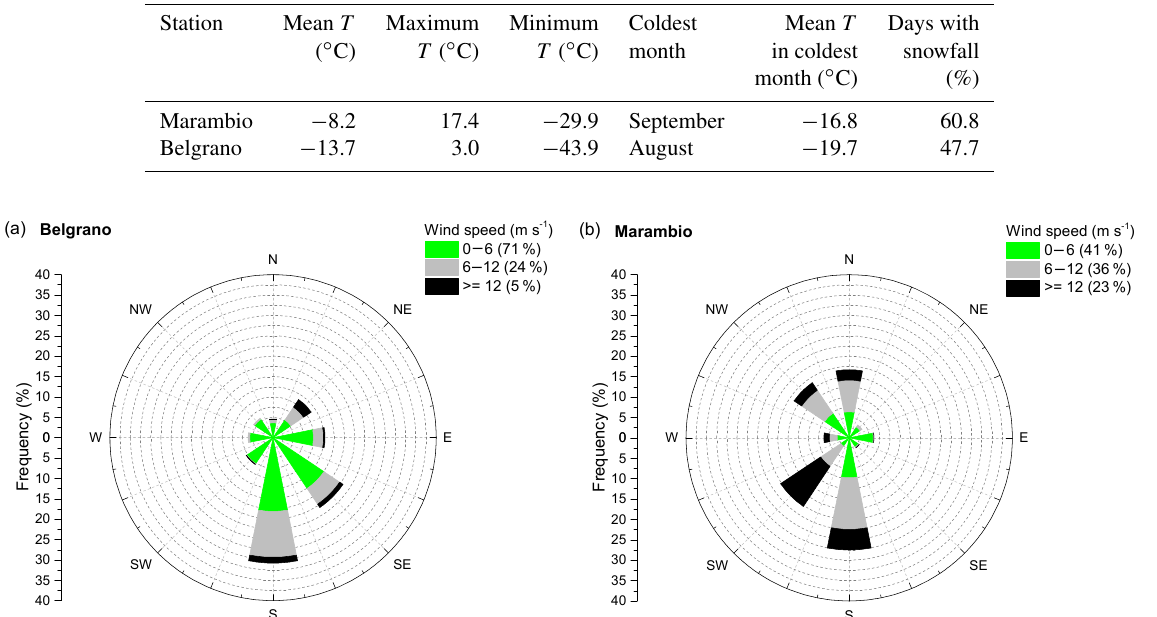
Fig. 9 the sea ice conditions during those days. The wind speed on those selected days was below 10 m s − 1 . As can be seen in Fig. 8, the maximum of BrO was located close to the surface, although its specific altitude depended on the day, always located below 1 km of altitude. Some days the peak of BrO was located just above the surface (e.g., 11 Novem- ber at Belgrano or 25 September at Marambio in Fig. 8;